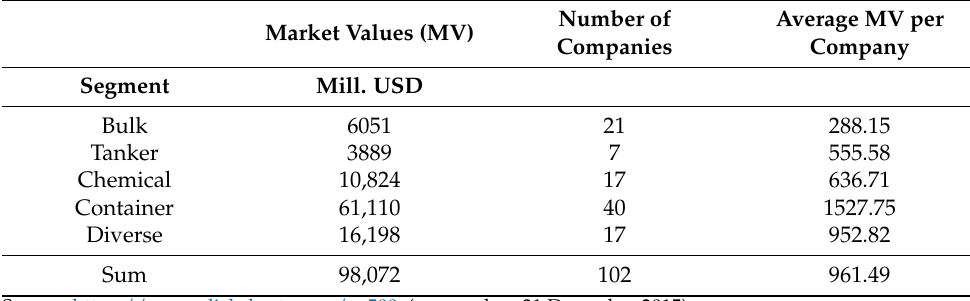
Table 8. Size of companies in each market